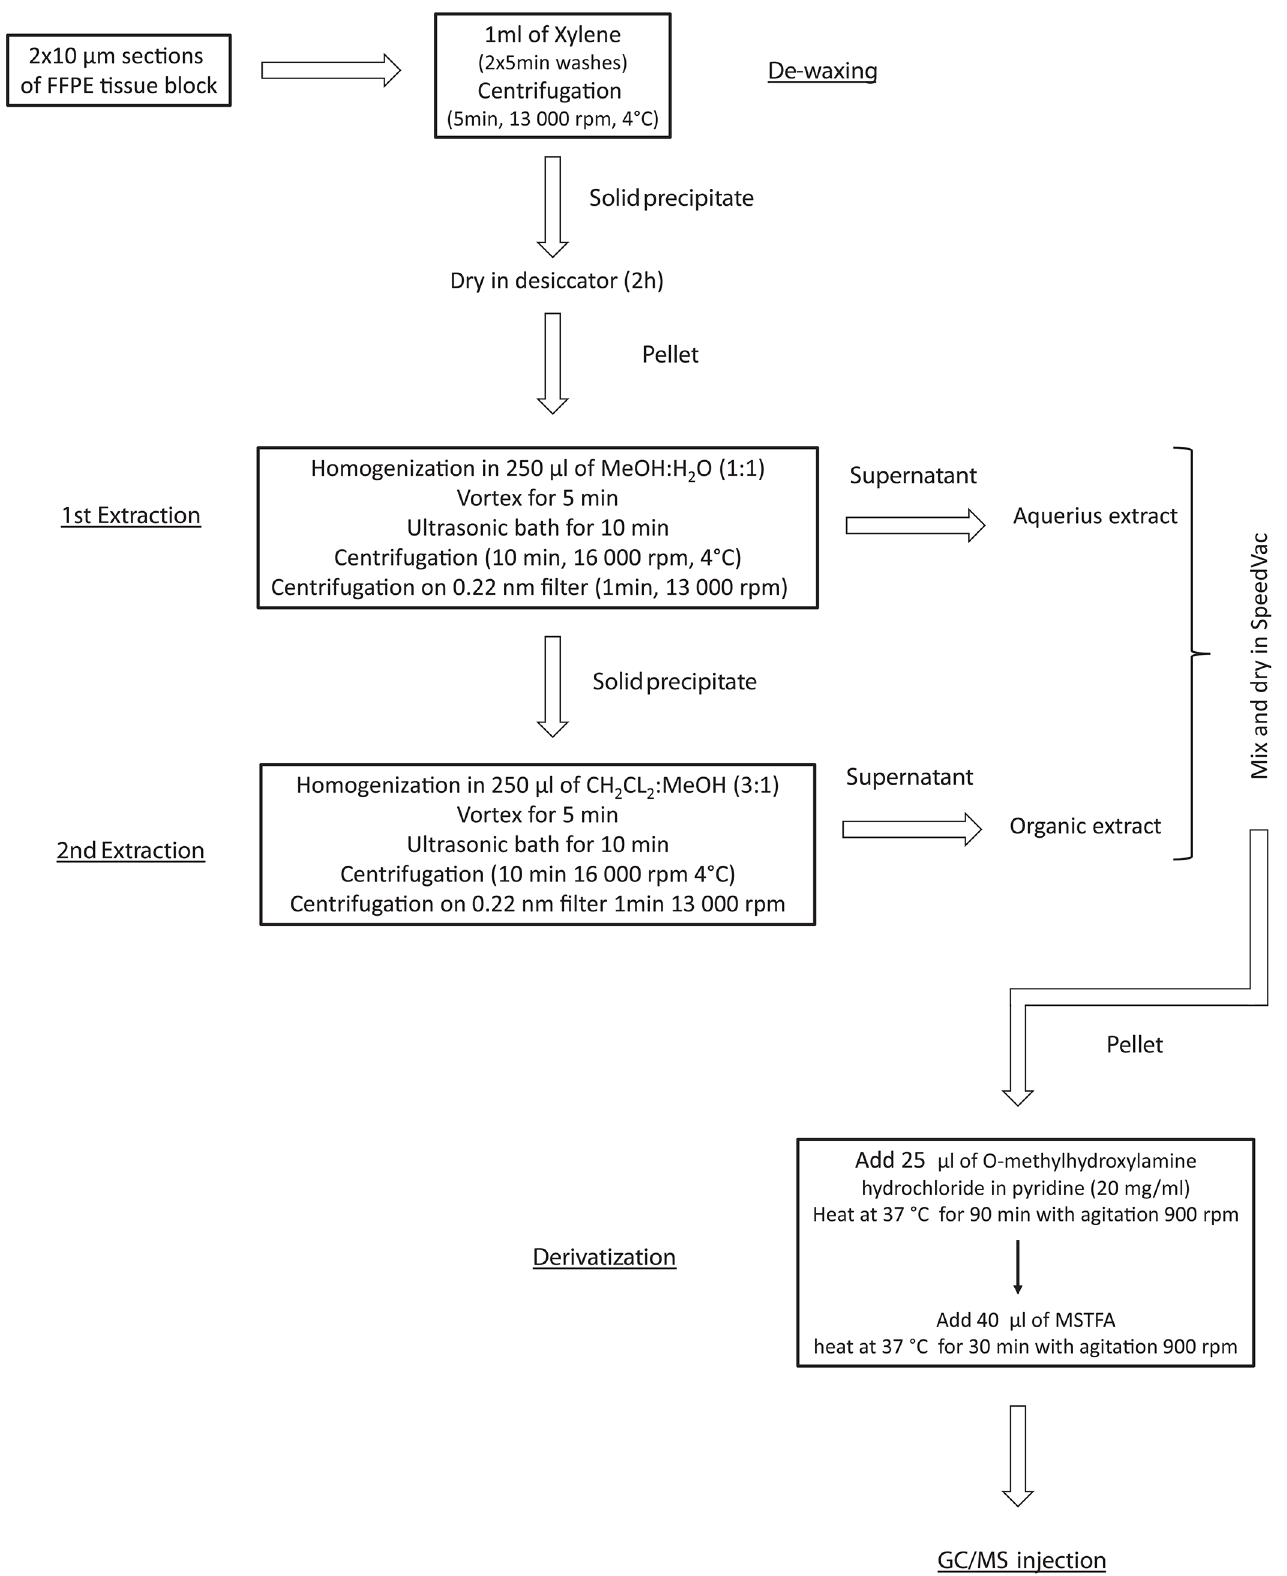
Fig 1. The general workflow of metabolite extraction from formalin-fixed paraffin-embedded tissue blocks for GC/MS analysis. doi:10.1371/journal.pone.0136902.g001 PLOS ONE | DOI:10.1371/journal.pone.0136902 September 8,